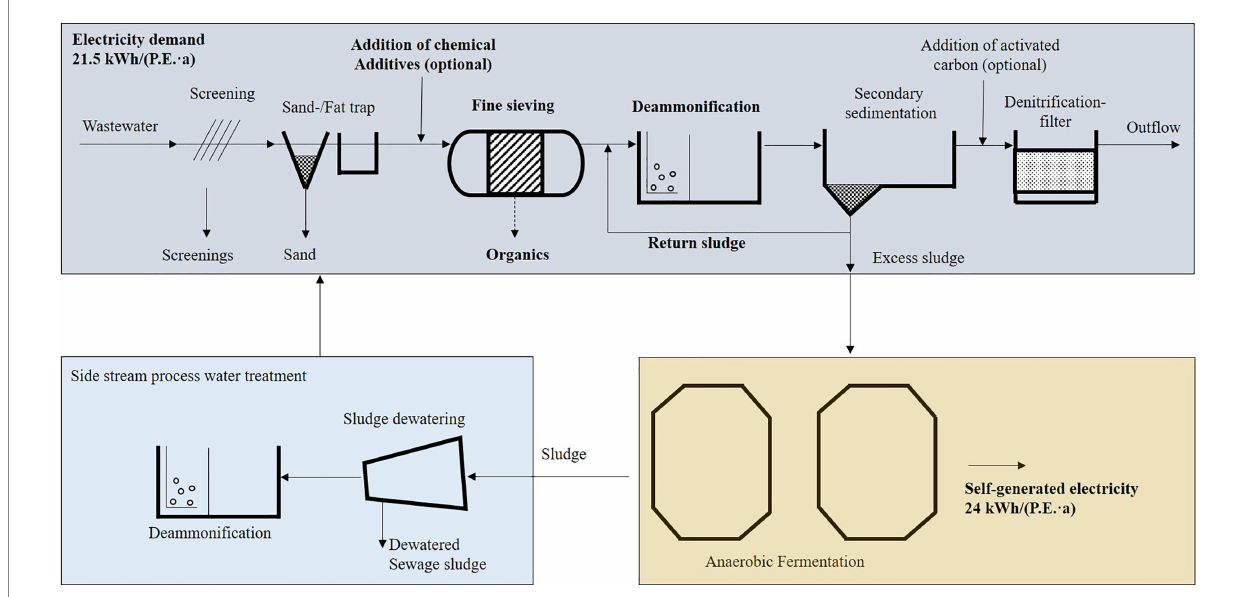
FIGURE 1 Conceptual model of a municipal wastewater treatment plant with mainstream deammonification depicting its energy saving and generating potential.